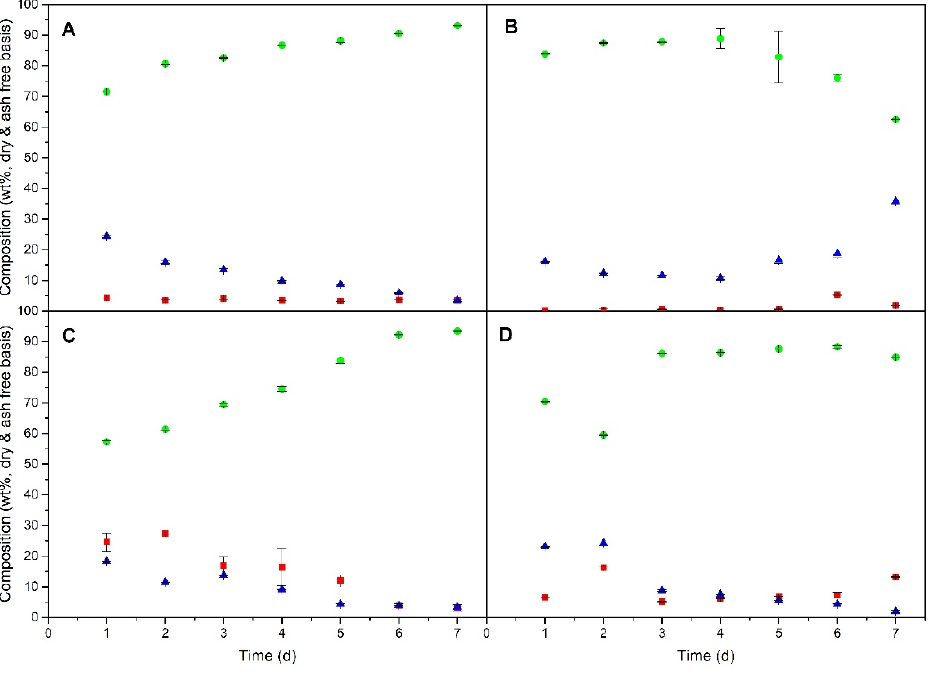
Figure 6. Time series of biomass composition (wt%, dry and ash free basis) of: ■ lipids, ● proteins and ▲ carbohydrates) for A. maxima in MC1 ( A ), C. vulgaris in MC4 ( B ), I. galbana in MC3 ( C ) and N. gaditana in MC4 ( D ). Conditions for all cultivations: inoculum:culture medium ratio of 5:45 and a photoperiod of 12:12 h.